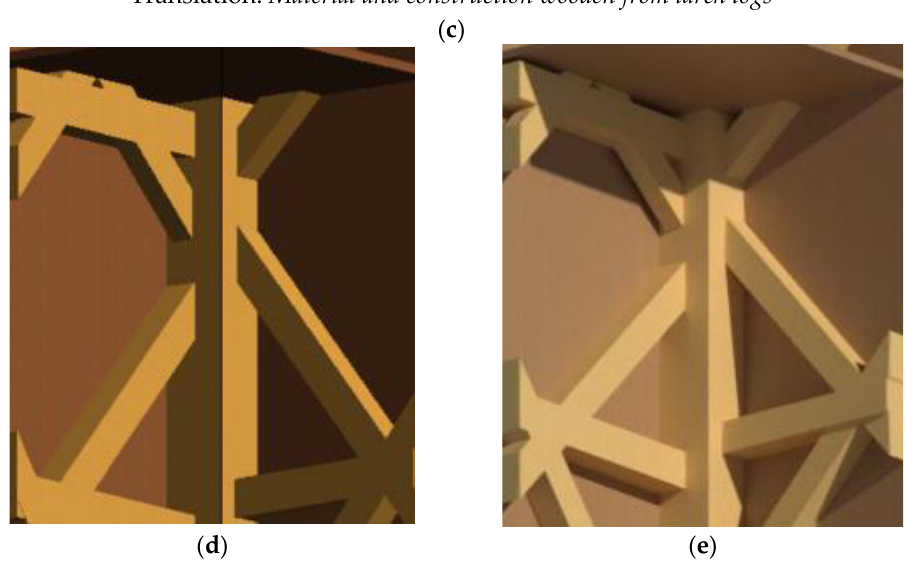
Figure 9. Generating a BIM model (structure column and beams): ( a ) real state (photo), ( b ) Identification of an element on a point cloud, ( c ) Identification of the construction material (description from the Monument Card), ( d ) part of the model BIM, ( e ) visualization of the object (reconstruction).